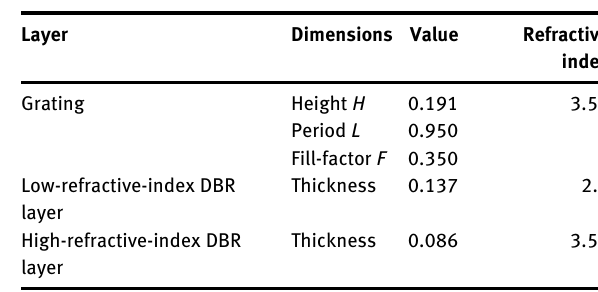
Table  : Geometrical details of the structure for unity